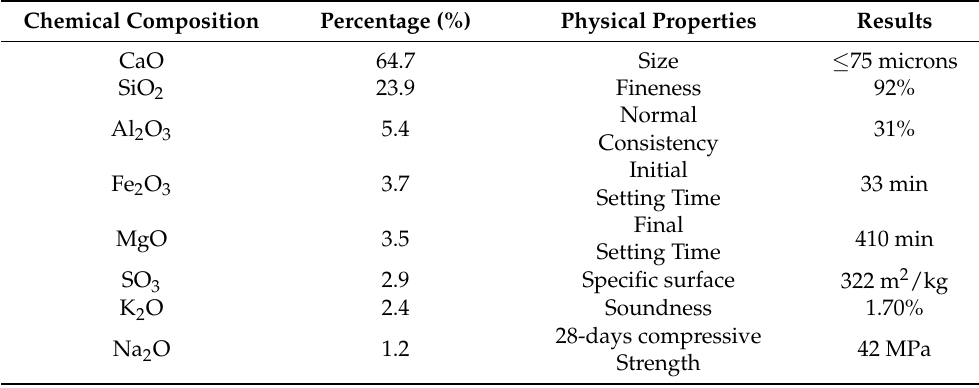
Table 1. Physical and chemical properties of Portland